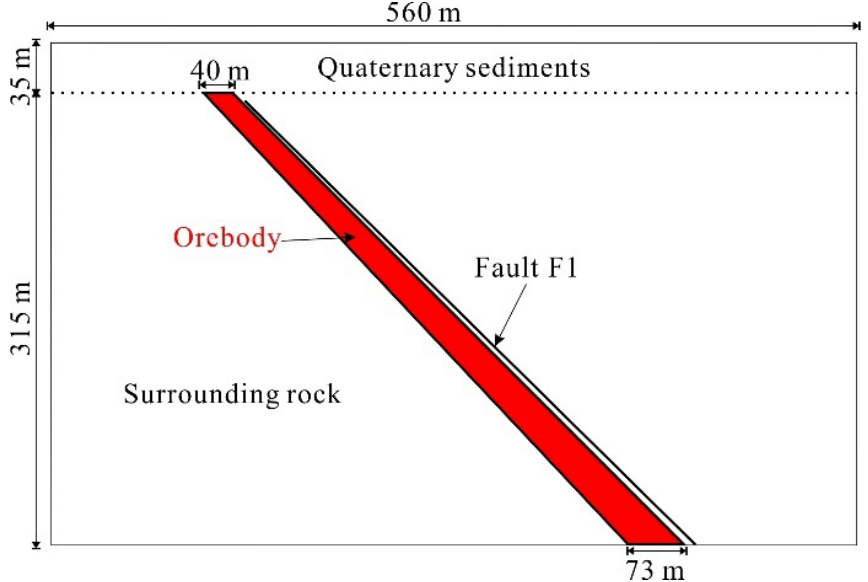
Figure 2. Simplified geologic profile of the study area.